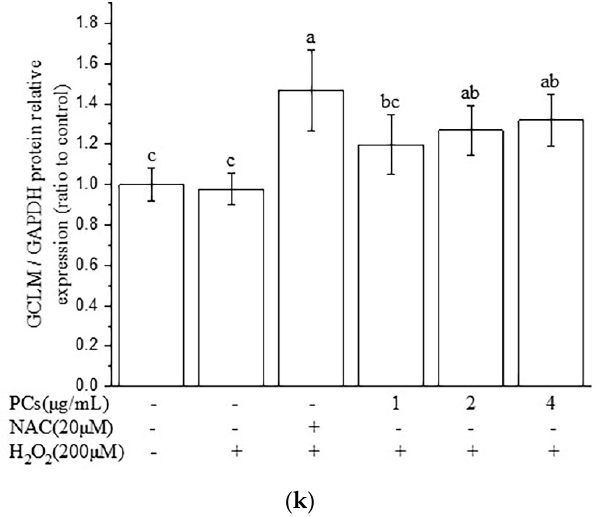
Figure 3. Effects of PCs on the Nrf2/ARE pathway in H 2 O 2 -treated PC12 cells. ( a ) Protein levels of Nrf2 and Keap1, as determined by Western blotting; ( b ) Nrf2/GAPDH protein relative expression (ratio to control); ( c ) Keap1/GAPDH protein relative expression (ratio to control); ( d ) protein expression levels of nuclear Nrf2 and cytoplasmic Nrf2, as determined by Western blotting; ( e ) nuclear Nrf2/LaminB protein relative expression (ratio to control); ( f ) cytoplasmic Nrf2/GAPDH protein relative expression (ratio to control); ( g ) protein levels of HO-1, NQO1, glutamate-cysteine ligase catalytic subunit (GCLC), and GCLM, as determined by Western blotting; ( h ) HO-1/GAPDH protein relative expression (ratio to control); ( i ) NQO1/GAPDH protein relative expression (ratio to control); ( j ) GCLC/GAPDH protein relative expression (ratio to control); ( k ) GCLM/GAPDH protein relative expression (ratio to control). Data are expressed as the mean ± SD. All experiments were conducted three times. Values with different letters above are significantly different ( p < 0.05, one-way ANOVA).